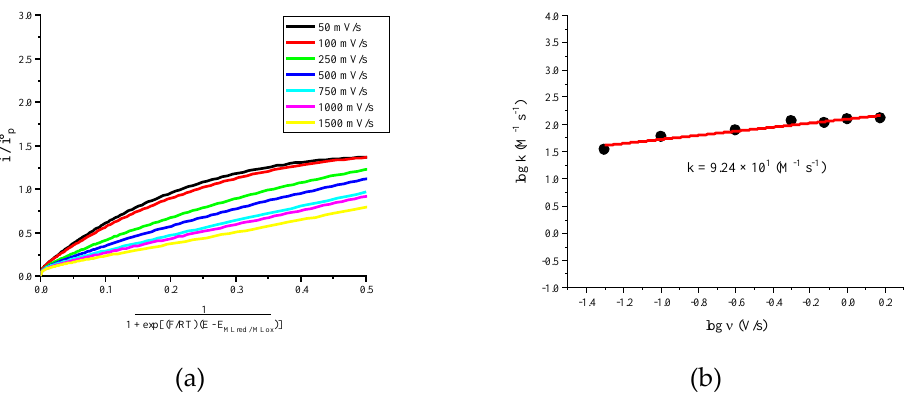
Figure 3. ( a ) FOWA of a 1 mM [Co II (bipy) 3 ](BF 4 ) 2 complex in MeCN with 0.1 M of TBAPF 6 as supporting electrolyte. ( b ) Logarithmic rate constant obtained from FOWA.